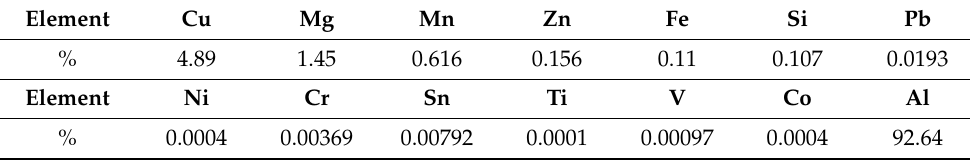
Table 1. Chemical composition of the as-received AA2024 alloy (weight